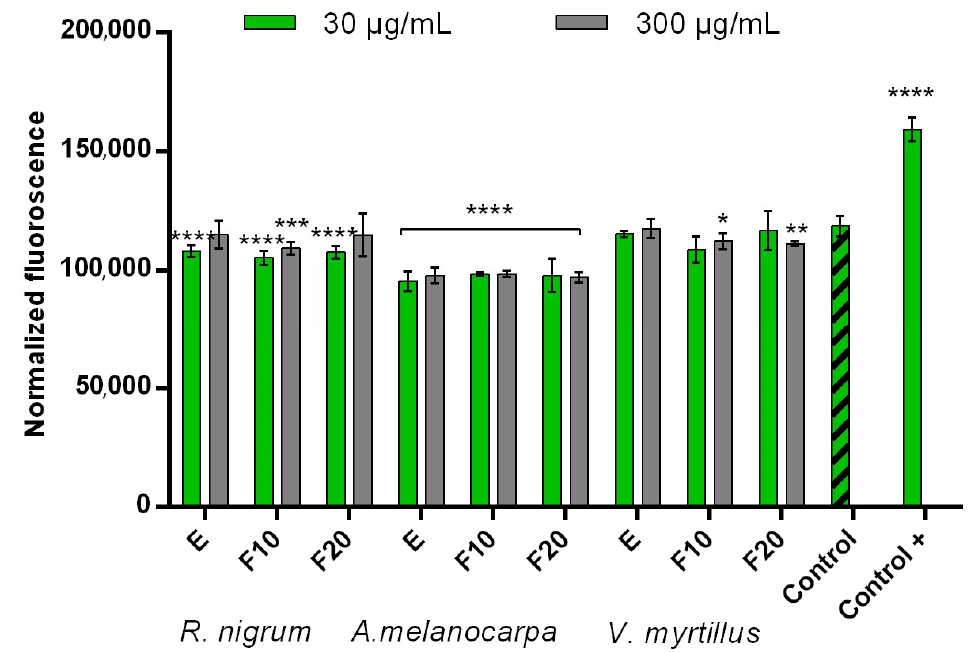
Figure 2. Intracellular ROS levels in BJ cells exposed to extracts (E) and ferments (F10 and F20) from R. nigrum , A. melanocarpa , and V. myrtillus . Data are the mean of three independent experiments in which each sample concentration was performed in triplicate. **** p < 0.0001, *** p < 0.001, ** p < 0.01, and * p < 0.05 compared to the control.